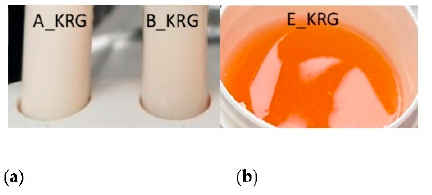
Figure 2. Optical properties of ( a ) NE A_KRG and B_KRG ( b ) hydrogel E_KRG.